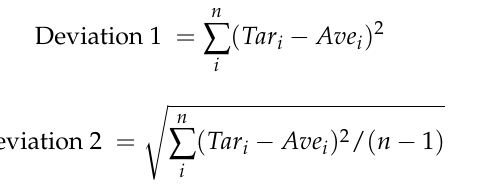
Table 2. The information of stochastic variables for the Gaussian stochastic earthquake